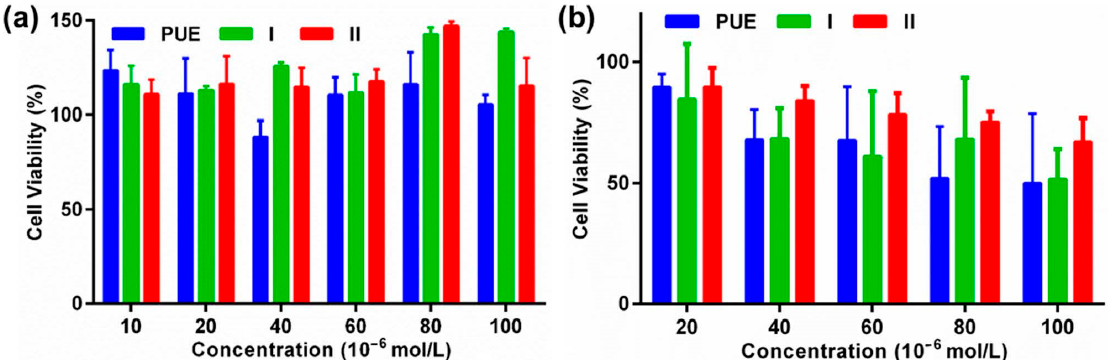
Figure 8. The cell viability data of PUE, I , and II against murine colon cancer CT-26 ( a ) and human kidney cell lines HEK-293 ( b ) upon culturing 24 h.